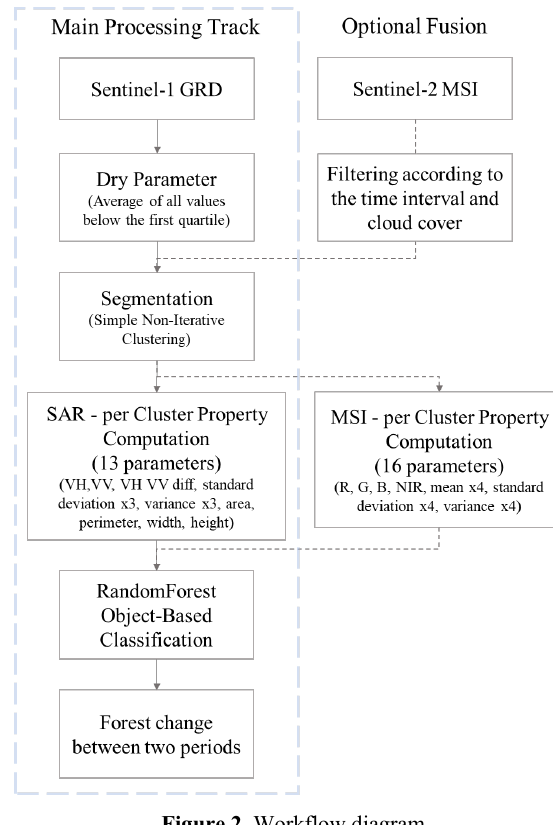
Figure 2 . Workflow diagram